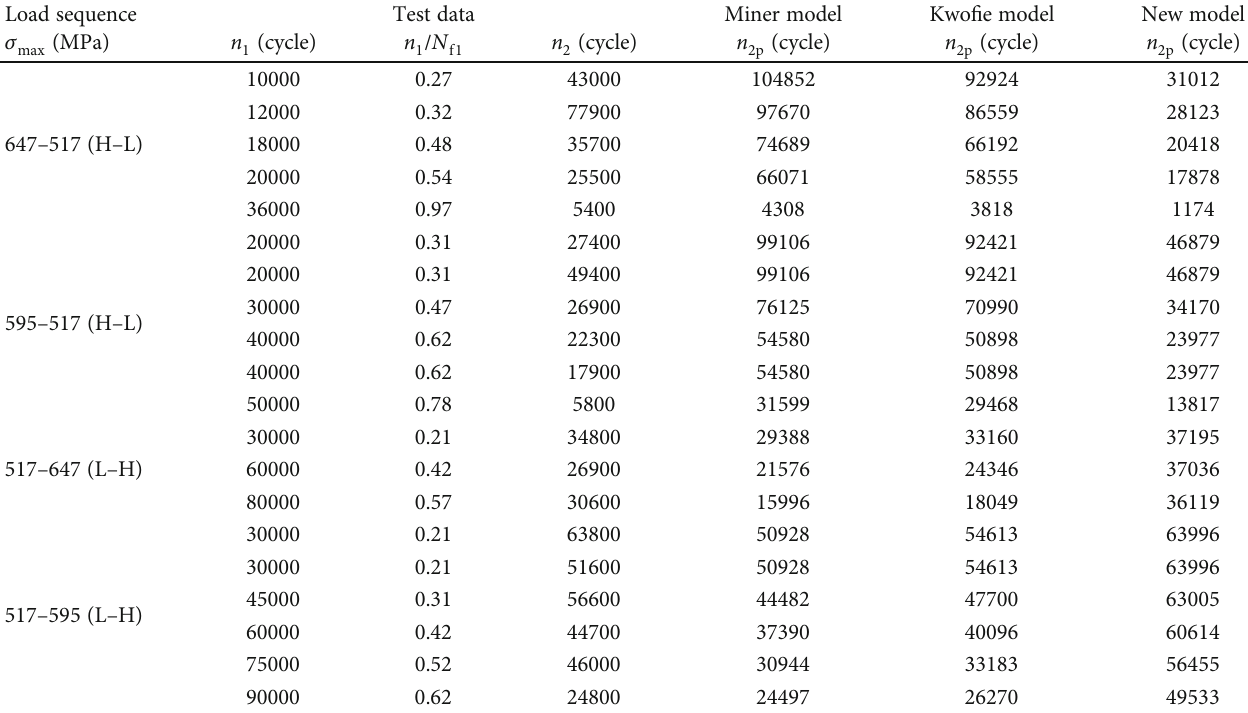
Table 2: Experimentally obtained and corresponding theoretical remaining life values predicted by the Miner, Kwo fi e, and proposed new model for the Ti-6Al-4V titanium alloy under two-level cyclic loading. Load